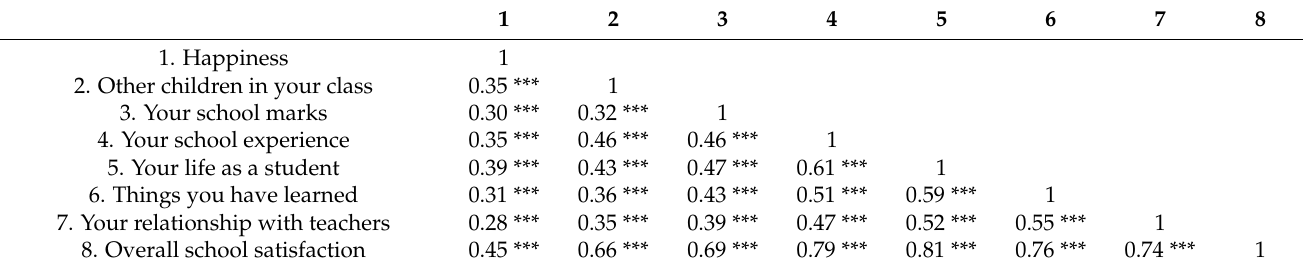
Table 4. Bivariate correlations between school satisfaction and happiness in the overall